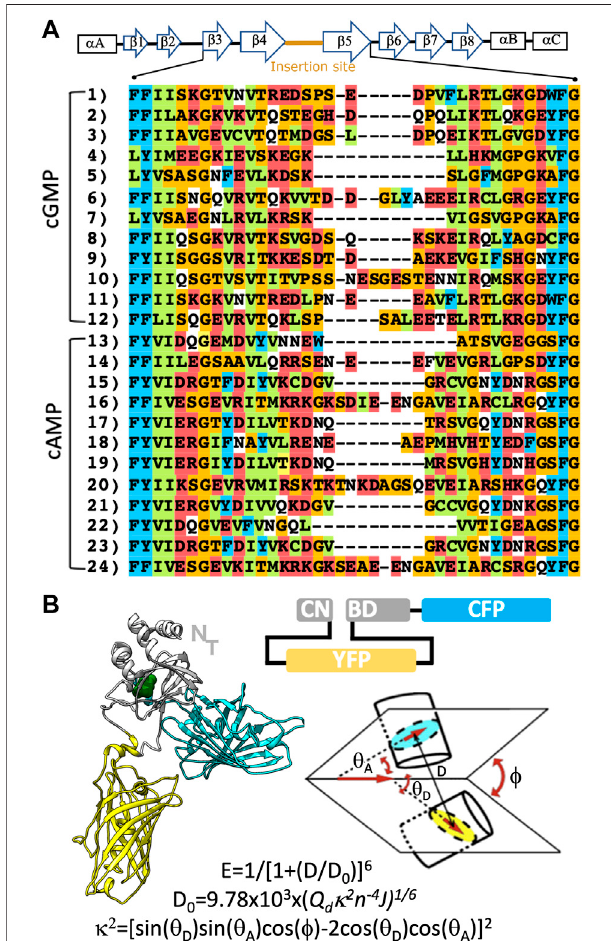
FIGURE 1 | Design of CUTie2. (A) Global secondary structure of a CNBD and multiple sequence alignment of related domains. Rectangles and arrows are used to indicate α -helices and β -strands. Sequences 1 to 12, and 13 to 24 correspond to cGMP and cAMP binding proteins, respectively. These correspond to the UNIPROT codes, for the cGMP binding domains: 1) Q13976, 2) Q13237, 3) A0A444U9Q8, 4) A0A443SJC3, 5) B0X970, 6) A0A4Y2N1F1, 7) A0A4Y2BIM3, 8) A0A419PY19, 9) A0A2P8Y1R0, 10) A0A3R7JPE0, 11) A0A444UAH2, 12) A0A0M4ENX8 and the cAMP binding modules: 13 and 14) P00514, 15 and 16) P12369, 17) A0A2J8TG41, 18) E0VRT6, 19 and 20) A0A091CJC2, 21) A0A556UFG6, 22) A9QQ52, 23 and 24) A0A384A0R8. Aminoacids are colored by physicochemical character according to CLUSTAL. (B) Cartoon representation and domain organization of the CUTie2 sensor. Notice that the N-terminal of the protein remains free to beeventuallyfusedtoarbitrarytargetingdomains.Theschematicarchitecture of the sensor and de fi nition of the geometric factors and equations used to calculate the FRET signal are provided on the right